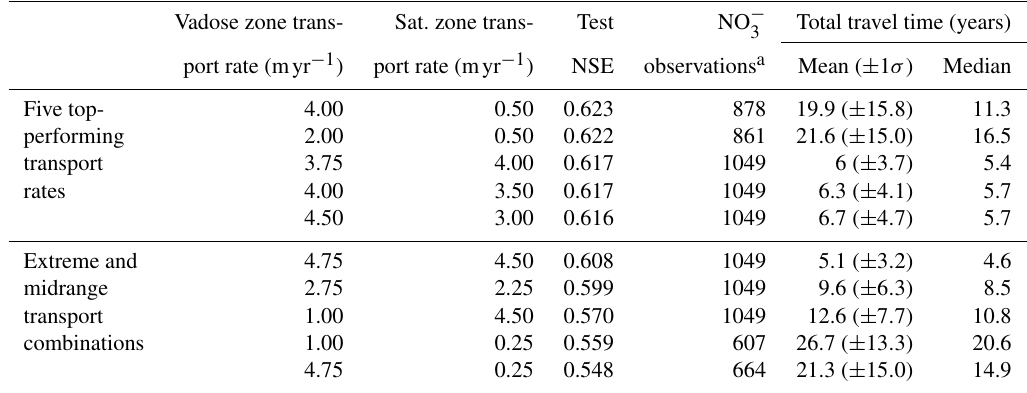
Table 2. Summary of 10 vadose and saturated zone transport rate combinations selected from 288 unique potential combinations from the analysis, including the dynamic